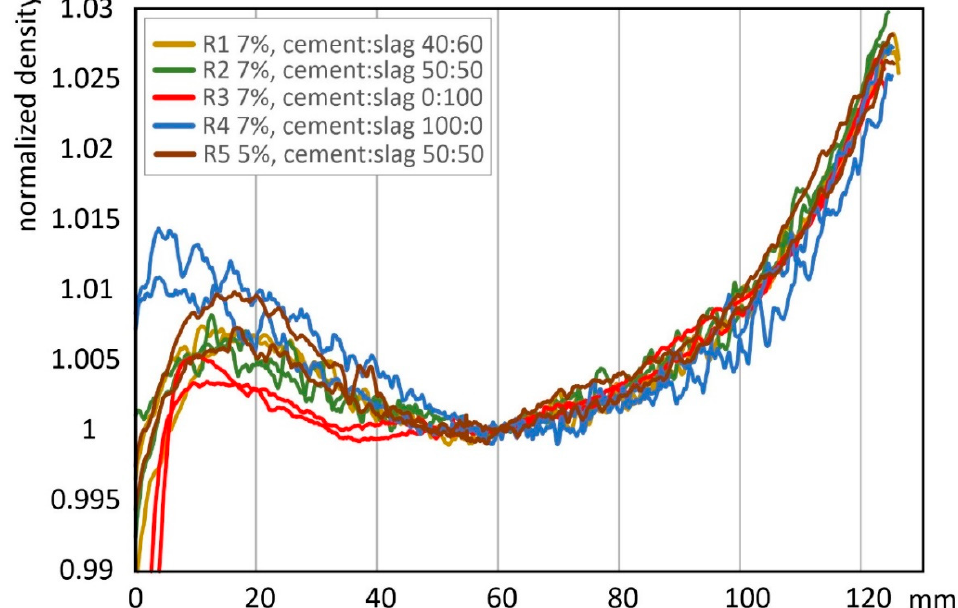
Figure 4. Average density / grayscale value of each XY-plane of each sample normalized by dividing by the density at z = 60 mm, showing similar trends for all samples. CPB specimens’ top is on the left. CPB sample (R1–R5) compositions are presented in Table 1.